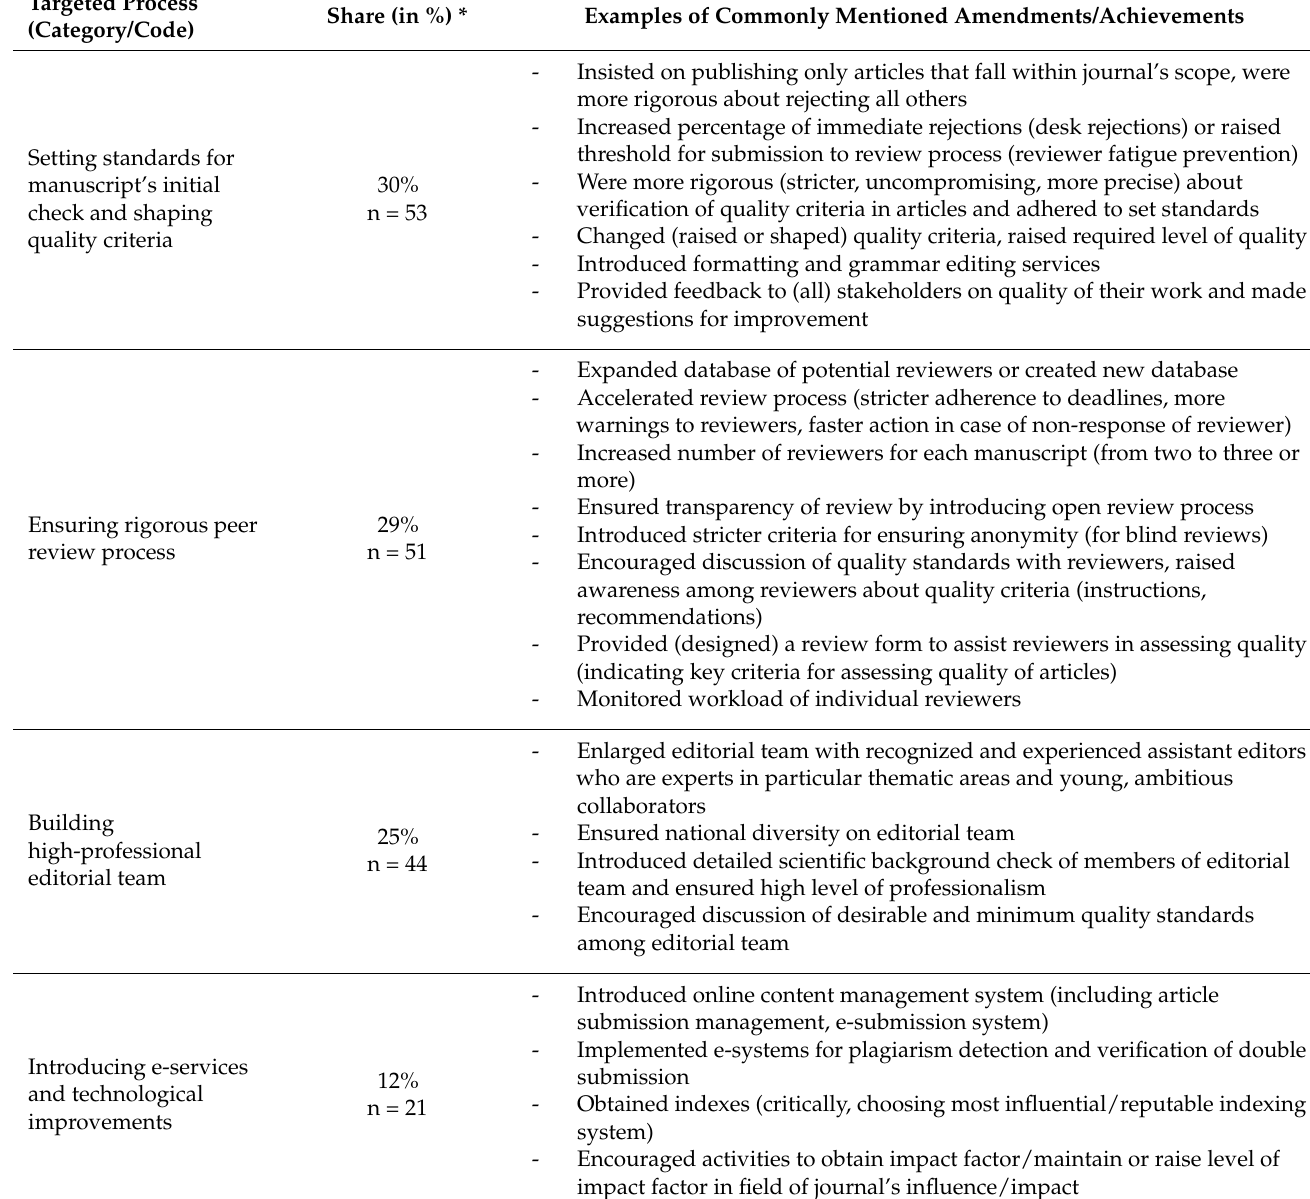
Table 2. Improvements in quality assessment processes implemented by journal